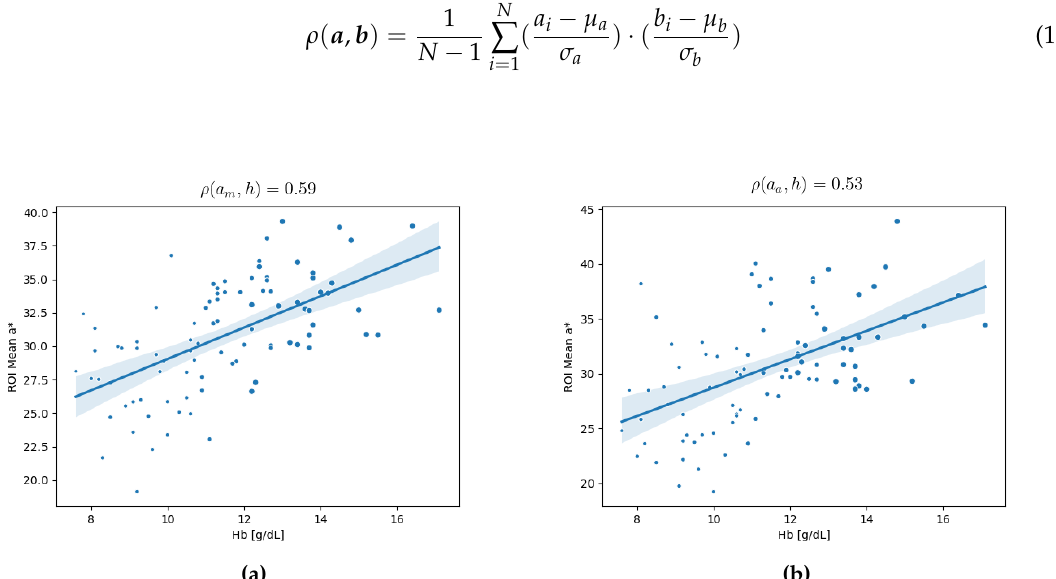
Figure 11. ( a ) Linear regression and strength of correlation between a* from manual segmentation and Hb g/dL standardized vectors. ( b ) Linear regression and strength of correlation between a* from automatic segmentation and Hb g/dL standardized